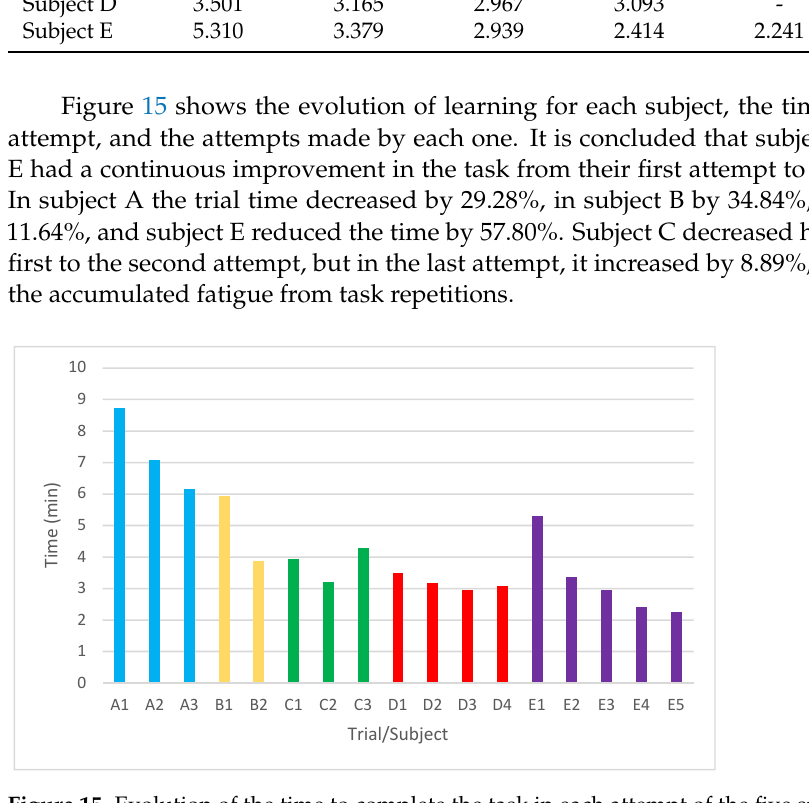
Table 3. Comparative results between subjects.